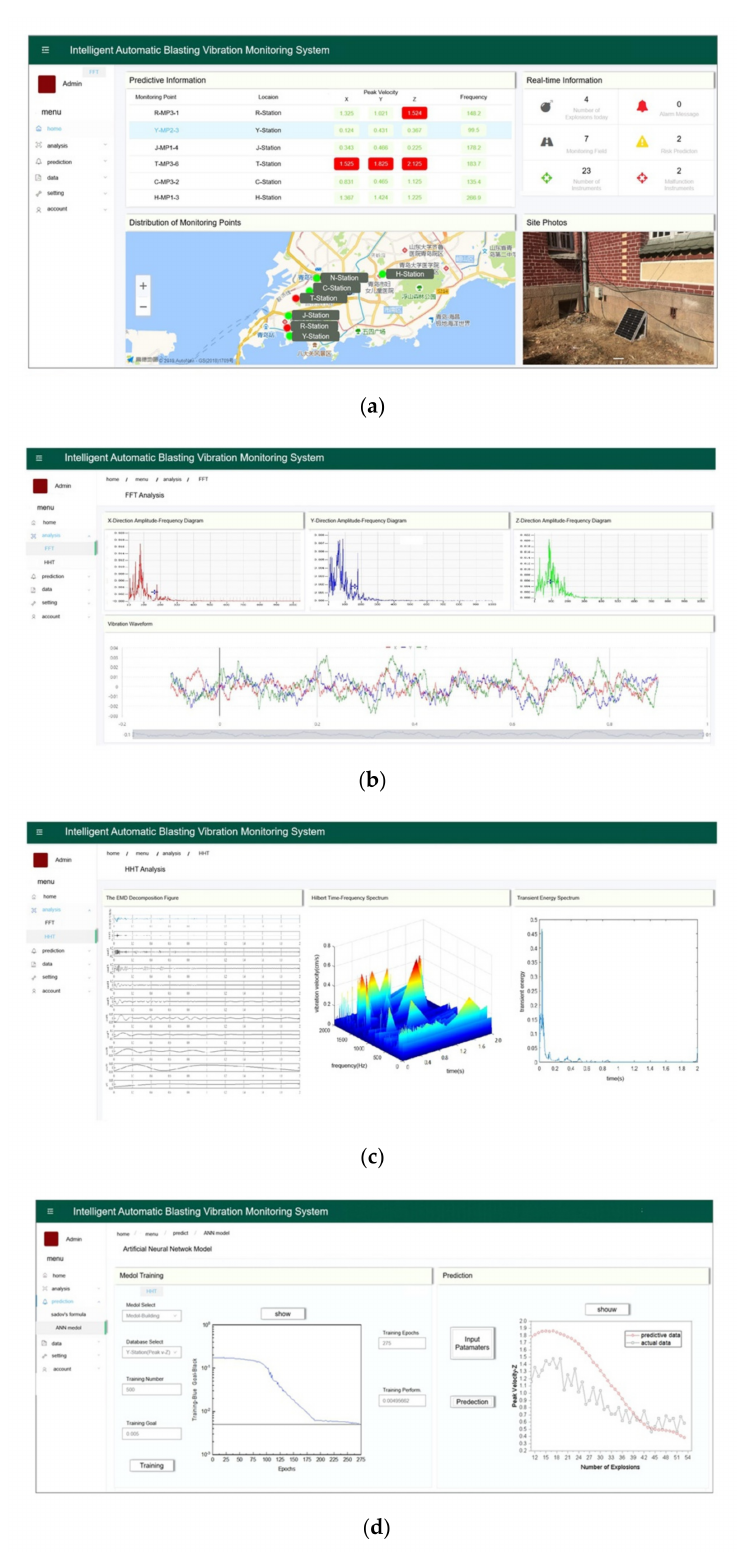
Figure 7. ( a ) The ‘home’ page of the intelligent automatic blasting vibration monitoring system. ( b ) The ’FFT analysis’ page of the intelligent automatic blasting vibration monitoring system. ( c ) The ’HHT analysis’ page of the intelligent automatic blasting vibration monitoring system. ( d ) The ‘train- ing and prediction of artificial neural network’ page of the intelligent automatic blasting vibration monitoring